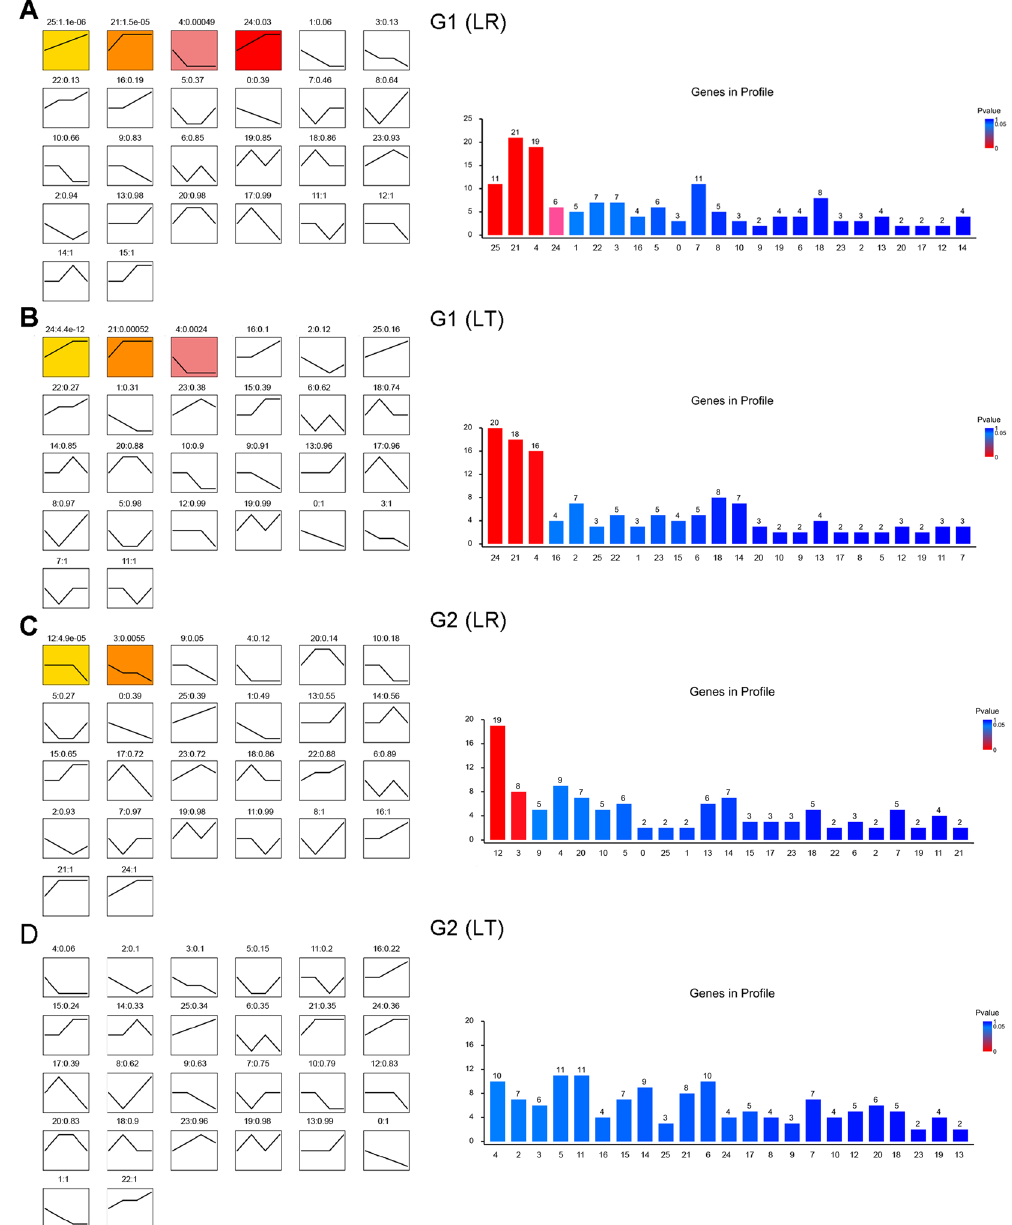
Figure 5. STEM analysis of gene expression profiles. ( A – D ) Each box indicates a model expression profile; the colored profiles represent profiles that reached statistical significance. The numbers in the box provide the order of the profile (upper left) and the P-value indicating significance (upper right). Histograms on the right show the number of genes involved in each expression profiles; and the lowest to highest P-values are marked from red to blue in the